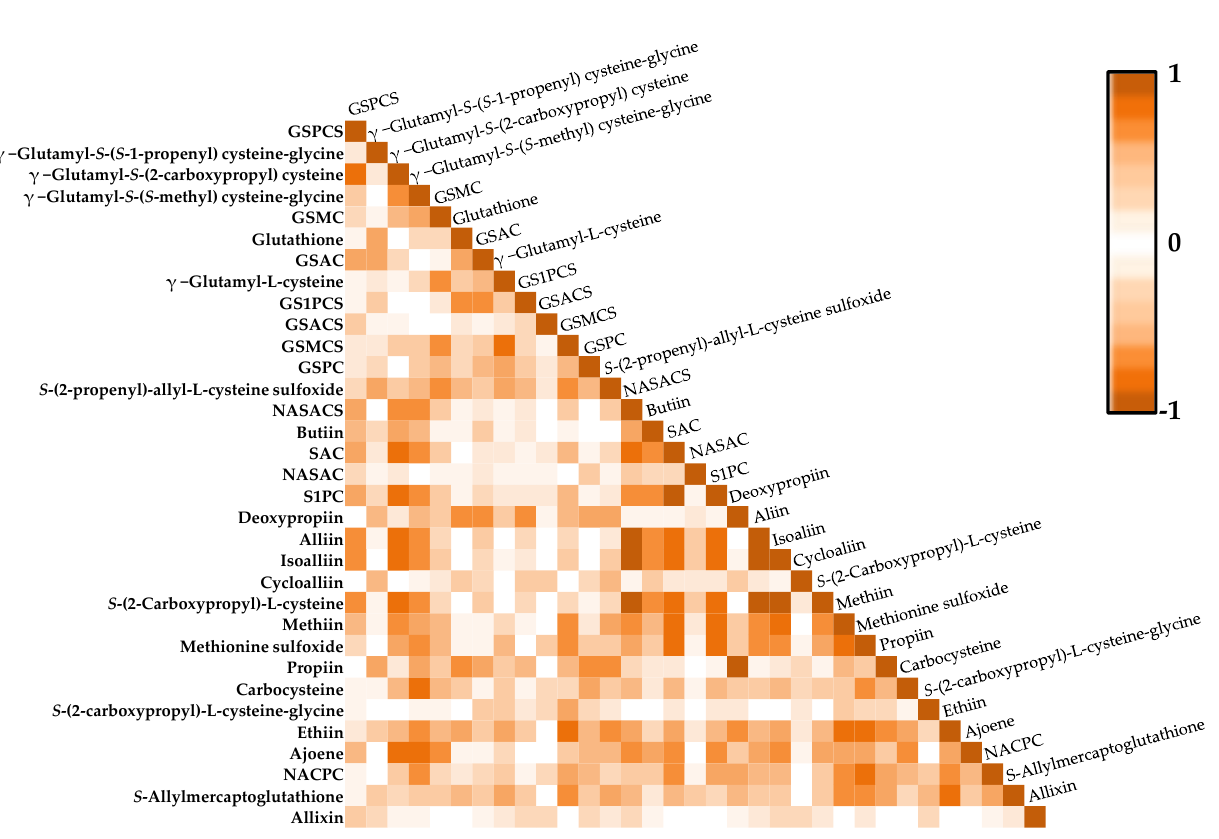
Figure 4. Correlation Heat Map based on Pearson correlation ( p < 0.05). The colour indicates the level of correlation: dark orange indicates a strong correlation between the compounds and white indicates no correlation. GSPCS: γ -Glutamyl- S -(propyl)-L-cysteine sulfoxide; GSMC: γ -Glutamyl- S -methyl-L-cysteine; GSAC: γ -Glutamyl- S -allyl-L-cysteine; GS1PCS: γ -Glutamyl- S -(1-propenyl)-L-cysteine sulfoxide; GSACS: γ -Glutamyl- S -allyl-L-cysteine sulfoxide: GSMCS: γ -Glutamyl- S -methyl-L-cysteine sulfoxide; GSPC: γ -Glutamyl- S -(propyl)-L-cysteine; NASACS: N -Acetyl- S -allyl-L-cysteine sulfoxide; SAC: S -Allyl-L-cysteine; NASAC: N -Acetyl- S -allyl-L-cysteine; S1PC: trans- S -(1-Propenyl)-L-cysteine; NACPC: N -Acetyl- S -(2-carboxypropyl)-L-cysteine;.